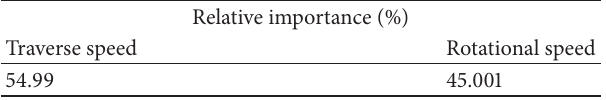
Table 5: Relative importance of input parameters on grain